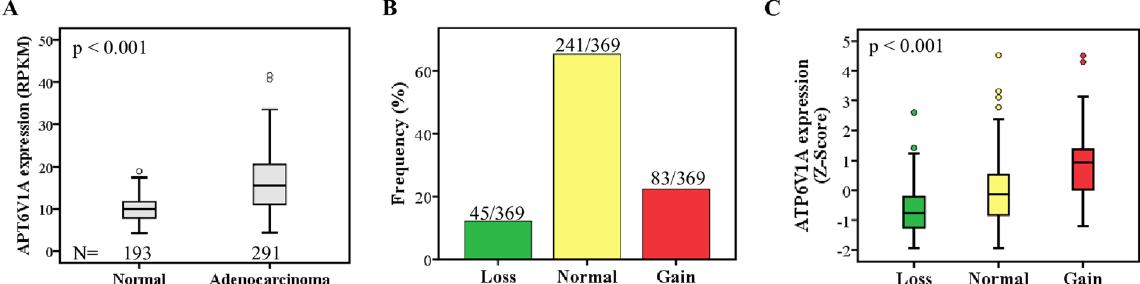
Figure 1. ATP6V1A gene is altered in gastric cancer patients. ( A ) Expression level of ATP6V1A is significantly elevated in GC in comparison to normal stomach tissues. ( B ) Frequency of DNA copy number alterations encompassing ATP6V1A gene in GC using TCGA dataset. ( C ) A significantly positive correlation was observed between DNA copy number and gene expression of ATP6V1A in TCGA